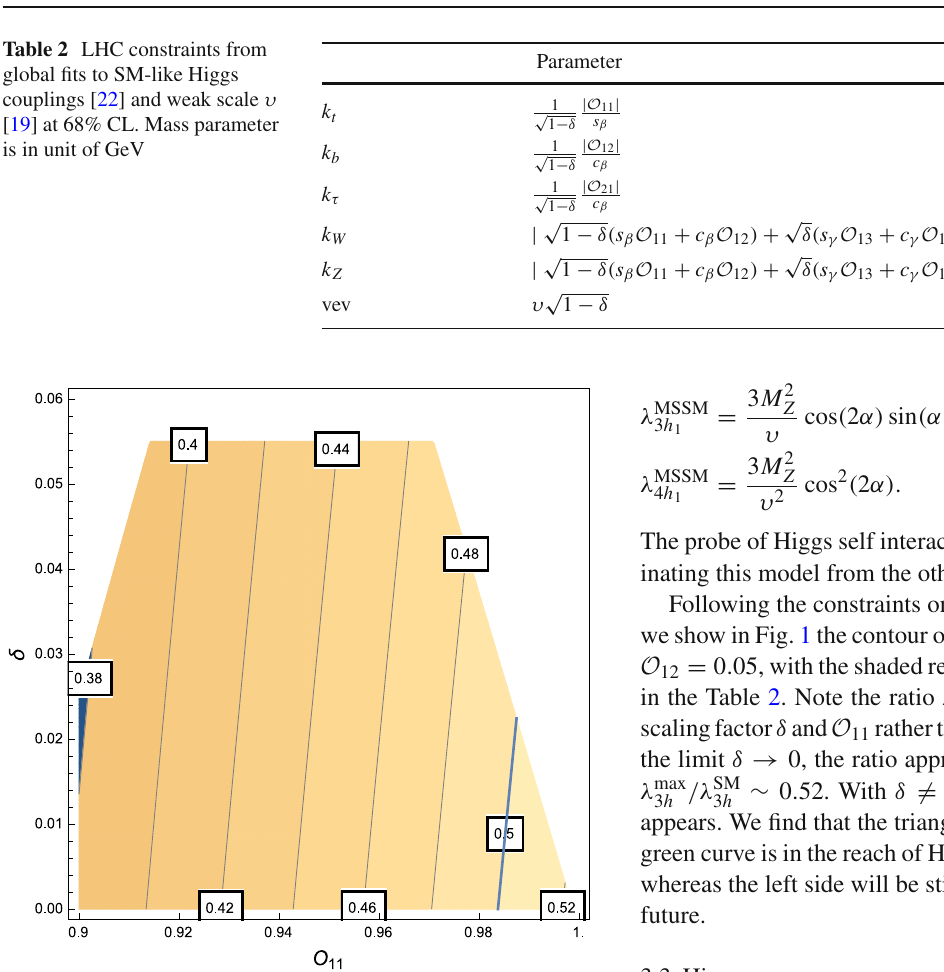
Fig. 1 The contour of λ 3 h /λ SM as function of δ and O 11 for tan β = 3 h 20 and O 12 = 0 . 05. The shaded region satisfies all constraints in the Table.2, where triangle region on the right side of green curve is in the reach of HL-LHC (14 TeV, 3ab − 1 )